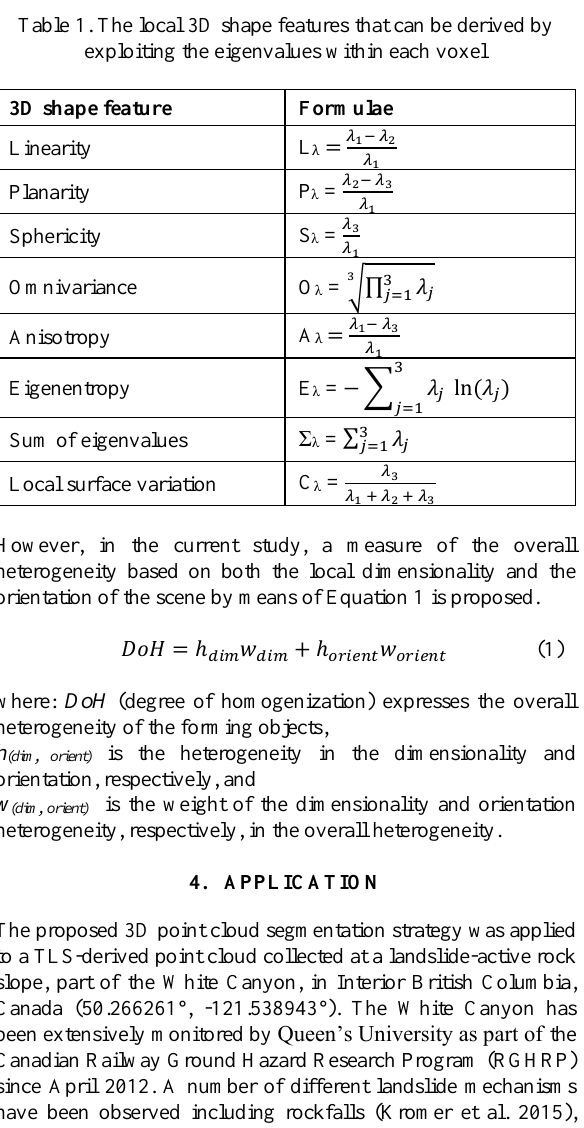
Figure 3. Part of the White Canyon. A) photo showing the overall complexity of slopes in the White Canyon, and B) the study area with spires (yellow frame) and overhanging blocks (light blue